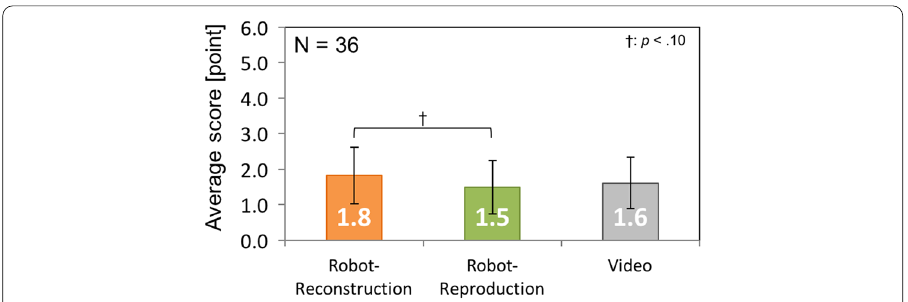
Fig. 11 Average scores of in-slide